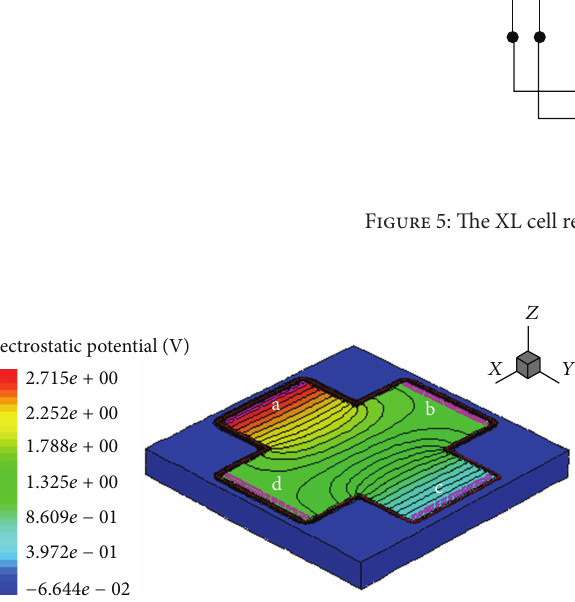
and 𝑇 the absolute temperature in K. In the case of silicon, 𝐸 𝑔 =1.12